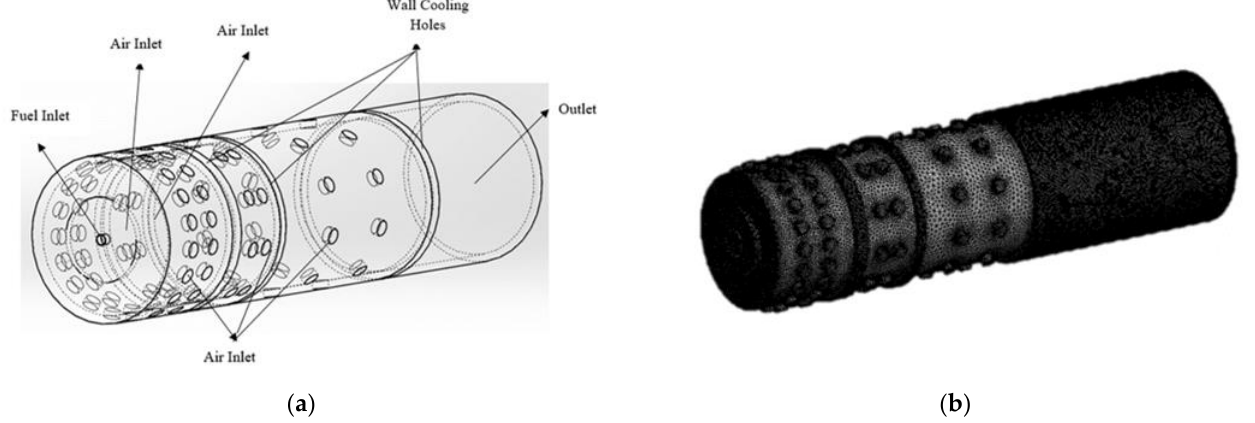
Figure 2. ( a ) The Geometry of the Combustor Chamber. ( b ) The Polyhedral Mesh of the Combustor